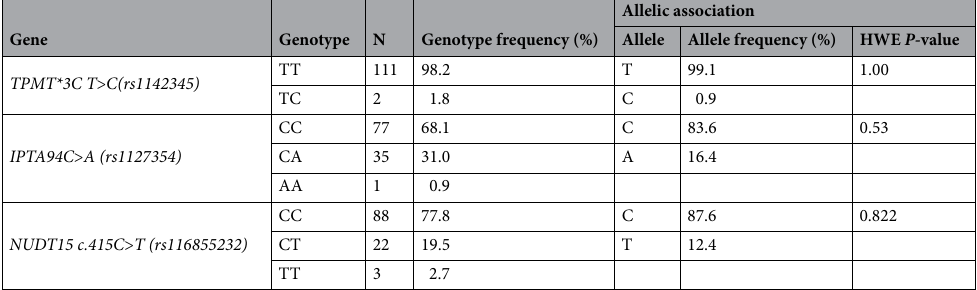
Table 2. Allele distribution of NUDT15 c.415C > T, ITPA 94C > A and TPMT*3C genotypes.